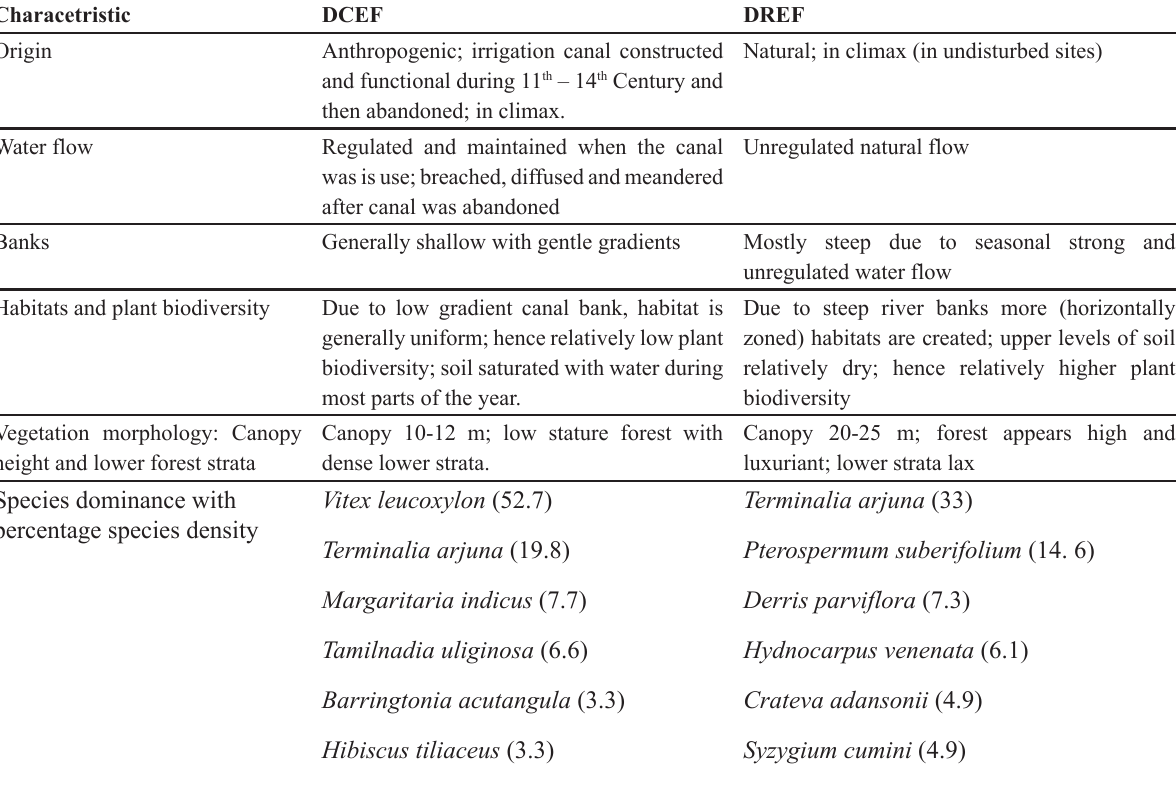
Table 3: Contrasting features of Dry Canal-associated Evergreen Forest (DCEF) and Dry Riverine Evergreen Forest (DREF). Characetristic DCEF DREF